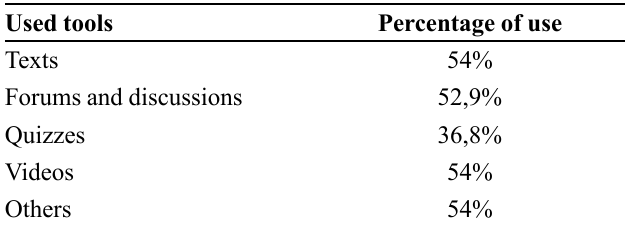
TABLE III - Used tools Used